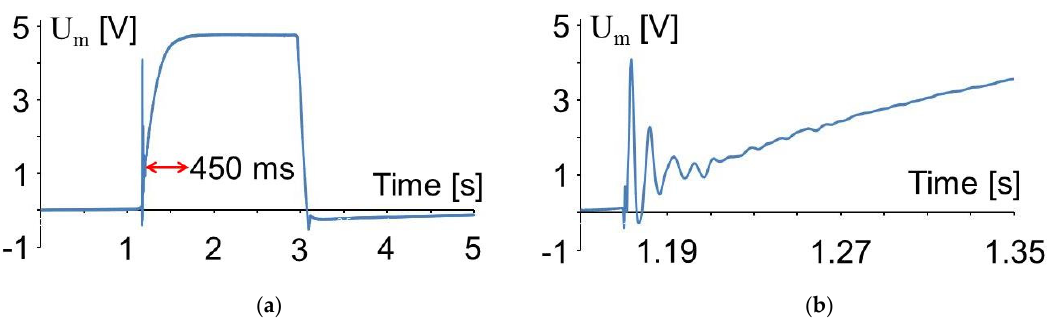
Figure 11. Voltage measured similar to Figure 10 , but without anvil vibrations ( a ) and time range around the touch of the machine top ( b ).